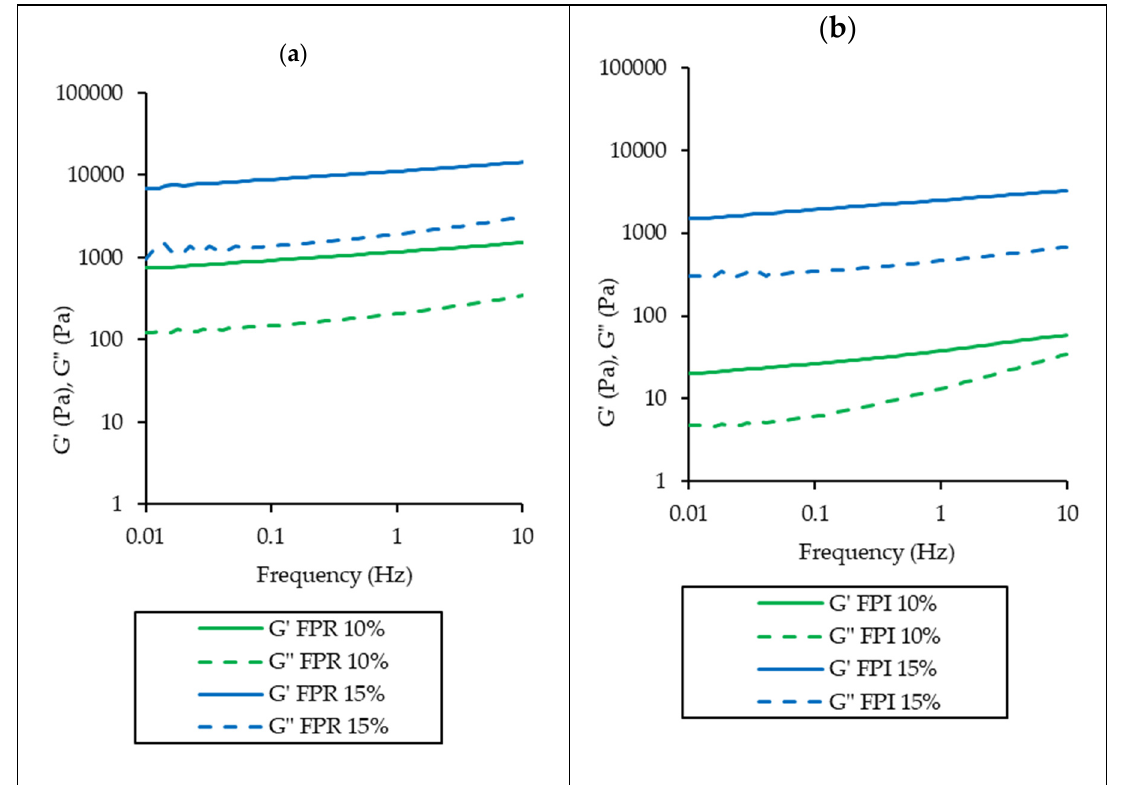
Figure 8. Rheological frequency sweeps for FPR ( a ) and FPI ( b ) at 10% and 15% protein. Storage modulus (Pa) and loss modulus (Pa) are shown as a function of frequency (Hz).